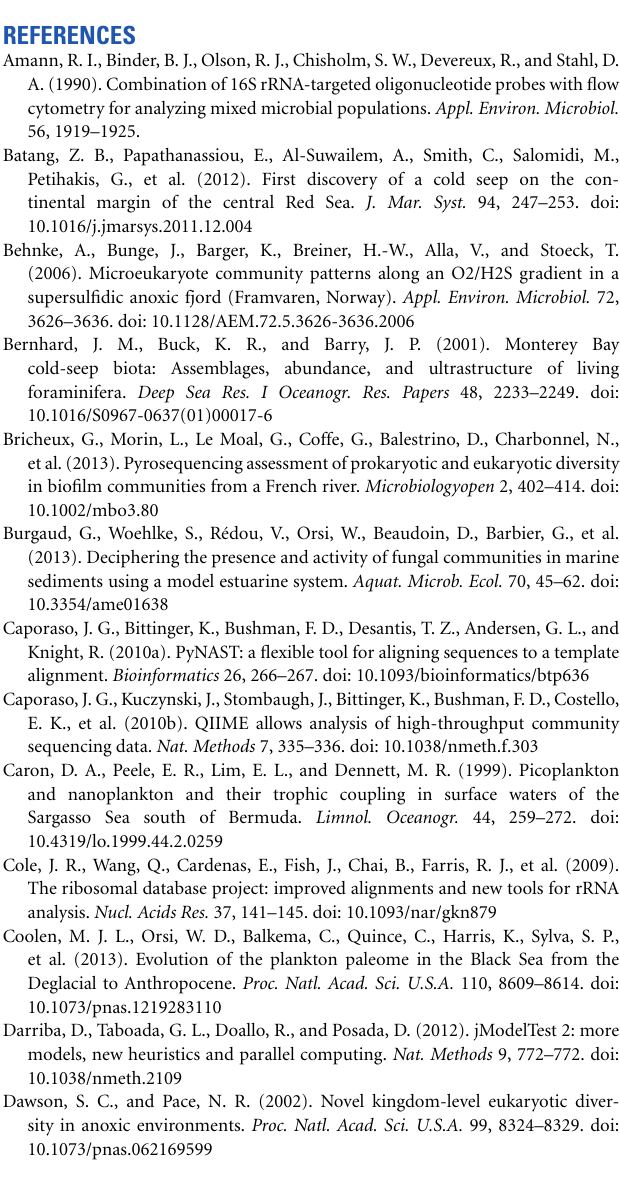
Figure S1 | Uncultured eukaryotes were similar to the members of clade 2. Figure S2 | Long branches formed by free-living Alveolata in DBI. The 3 OTUs, DBI-298, DBI-164, and DBI-236, represented 77% of the amplicon reads of the 18S rRNA genes from the interface between the bottom water and the brine pool. The maximum-likelihood tree was based on 1000 bootstrap replicates, and bootstrap values > 50 are